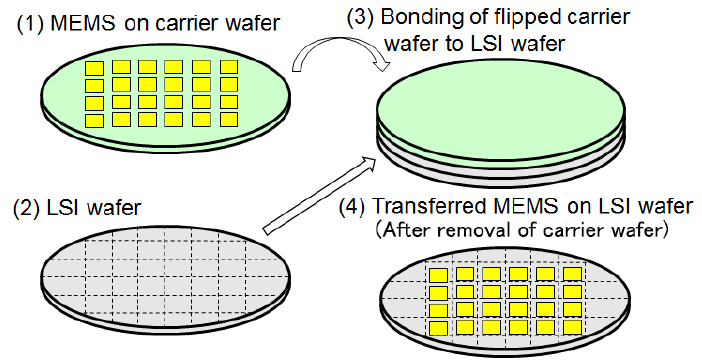
Figure 2. Concept of the heterogeneous integration by the wafer-level transfer.